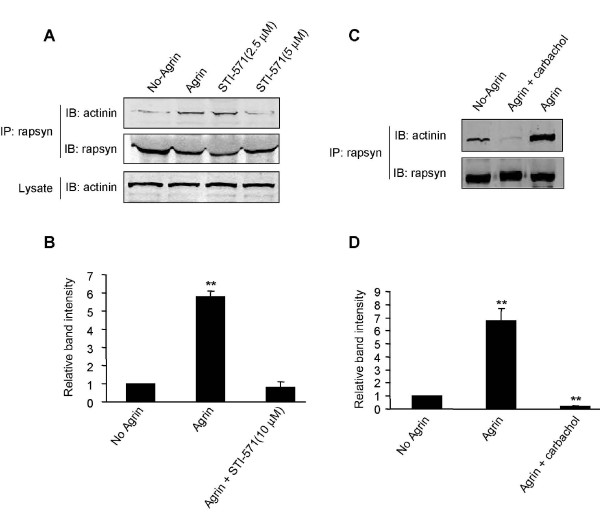
Disruption of the rapsyn-α-actinin interaction by Abl inhibition and cholinergic stimulation. (A) C2C12 myotubes were treated with agrin in the presence of different concentrations of STI-571. The interaction between rapsyn and α-actinin was characterized as in Fig. 2. (B) Quantification of (A). Data represent mean ± SEM of three experiments. **, p < 0.01, two-tailed Student's paired t test. (C) C2C12 myotubes were treated with or without agrin for 18 hr. After washing, agrin-treated myotubes were incubated with 10 μM carbachol. The carbachol treatment significantly decreased the rapsyn-α-actinin interaction not only compared to agrin-treated but also untreated myotubes. (D) Quantification of (C). Data represent mean ± SEM of three experiments. **, p < 0.01, by two-tailed Student's paired t test.